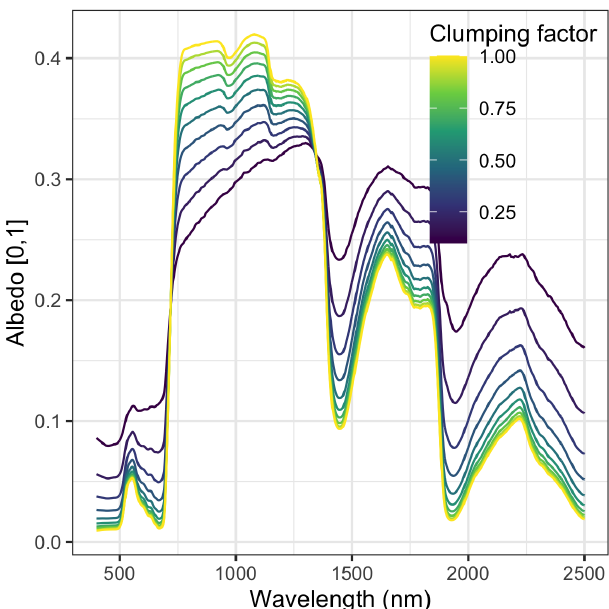
Figure A2. Same as above but with LAI fixed to 3 and varying clumping factor ( q